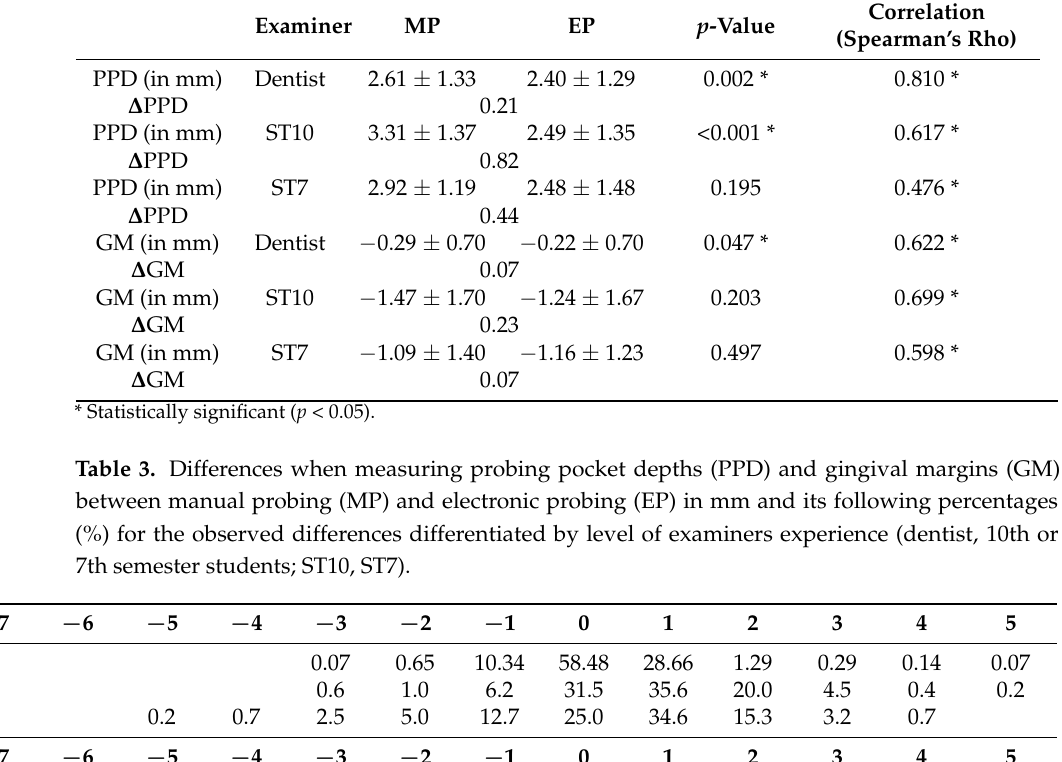
Table 2. Mean probing pocket depths (PPD) and gingival margins (GM) ( ± standard deviations) measured either with manual probe (MP) or electronic probe (EP) differentiated by level of examiner’s